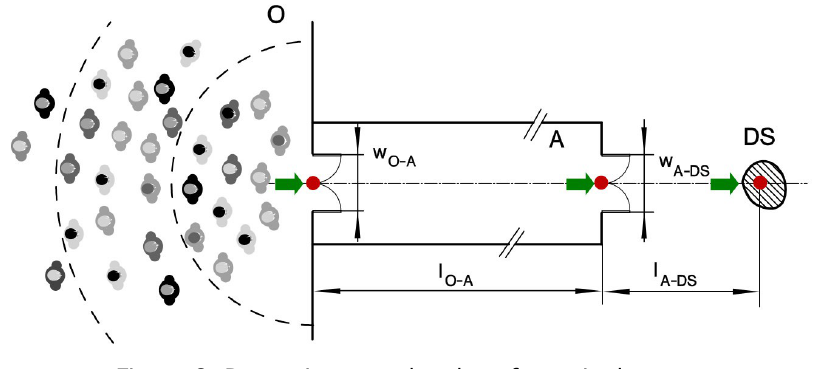
Figure 8. Dynamic network values for a single